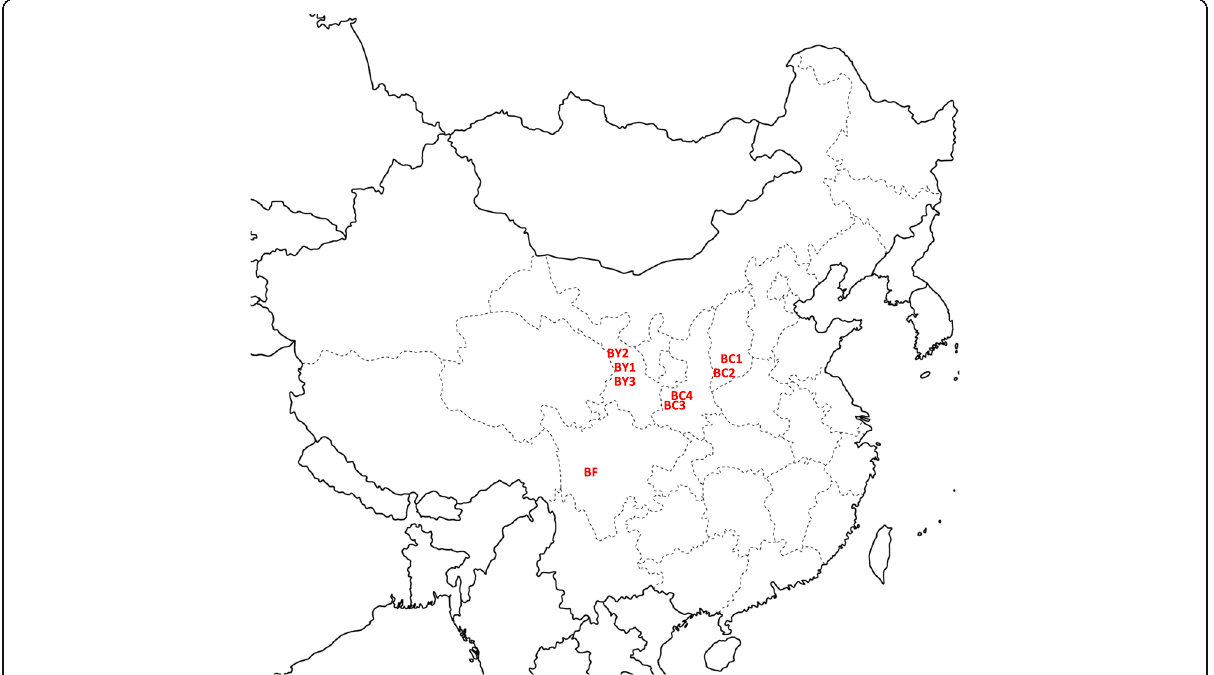
Fig. 2 The locations of harvest of Bupleurum plants. (The blank map was obtained from a free Baidu library https://wenku.baidu.com/, and then the locations were marked on the map by the